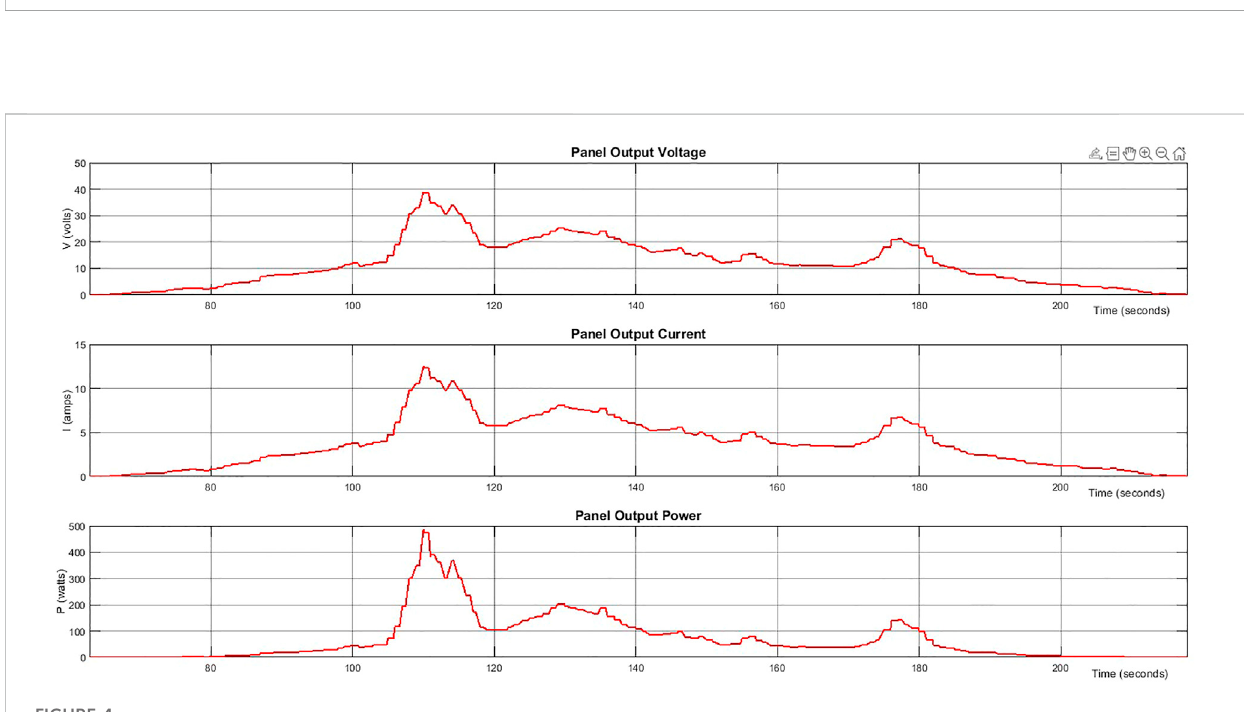
FIGURE 4 Solar panel output voltage, current, and